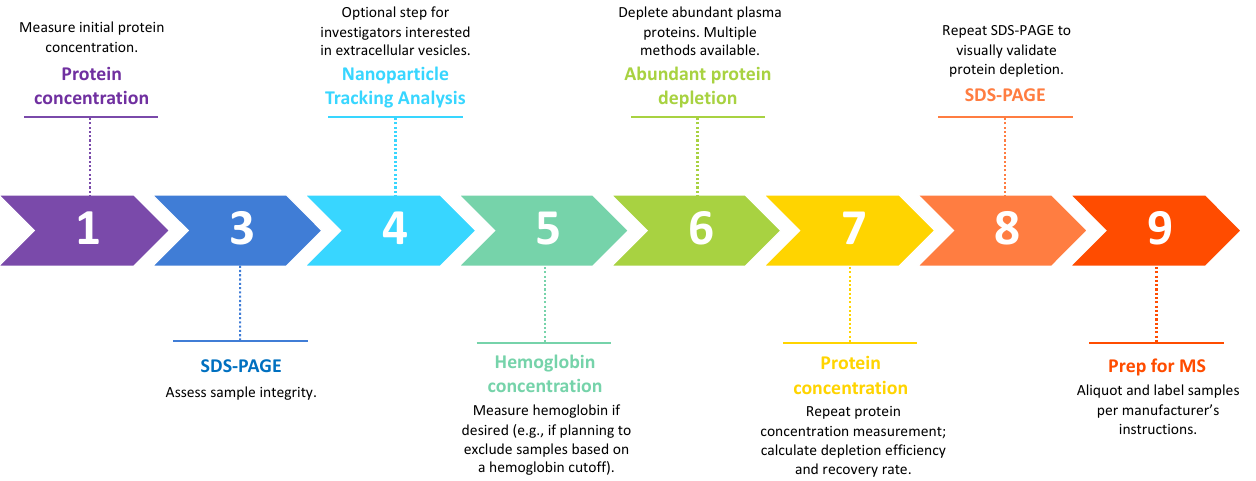
Figure 1. Suggested workflow for sample validation and processing. Protein concentration and sample integrity should be assessed prior to analysis. Depending on the investigators’ goals, EVs and hemoglobin may be quantified prior to further processing. Abundant proteins should be depleted and concentration should be reassessed to ensure sufficient depth of coverage. SDS-PAGE can then be repeated to validate prior steps before proceeding with MS.